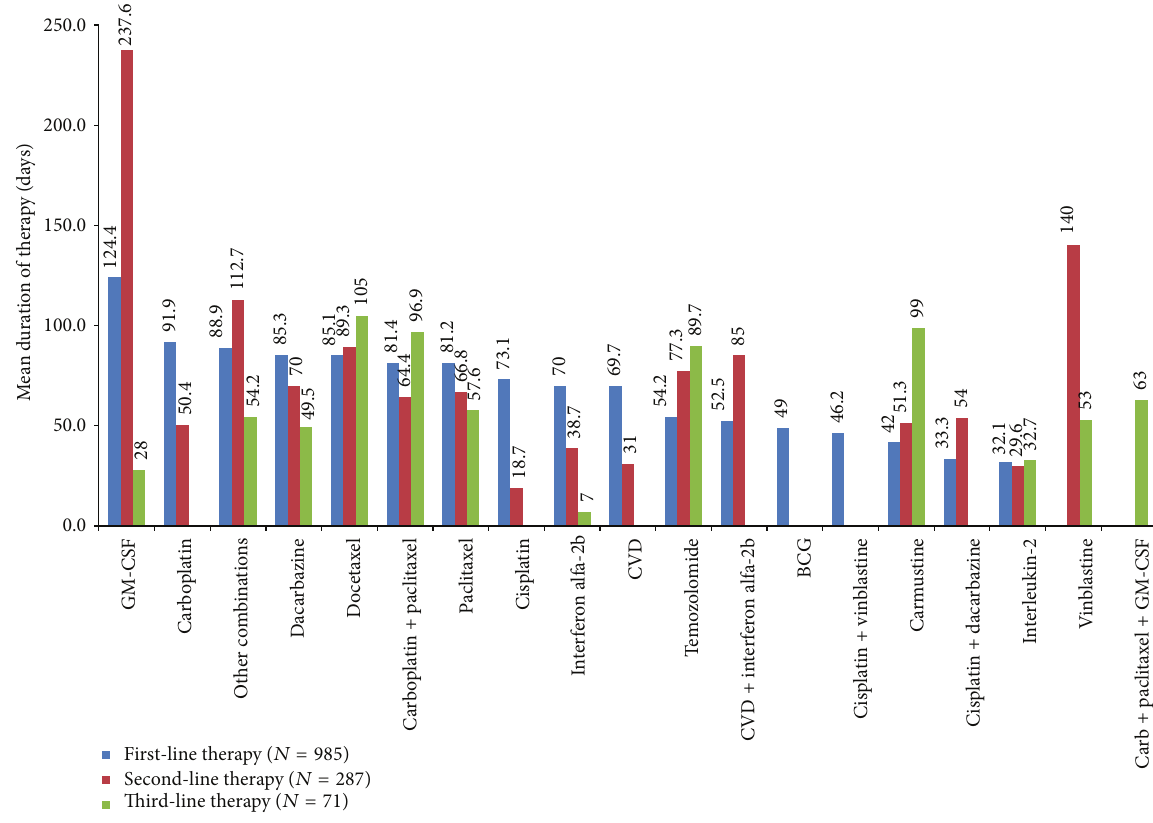
Figure 3: Treatment duration by line of